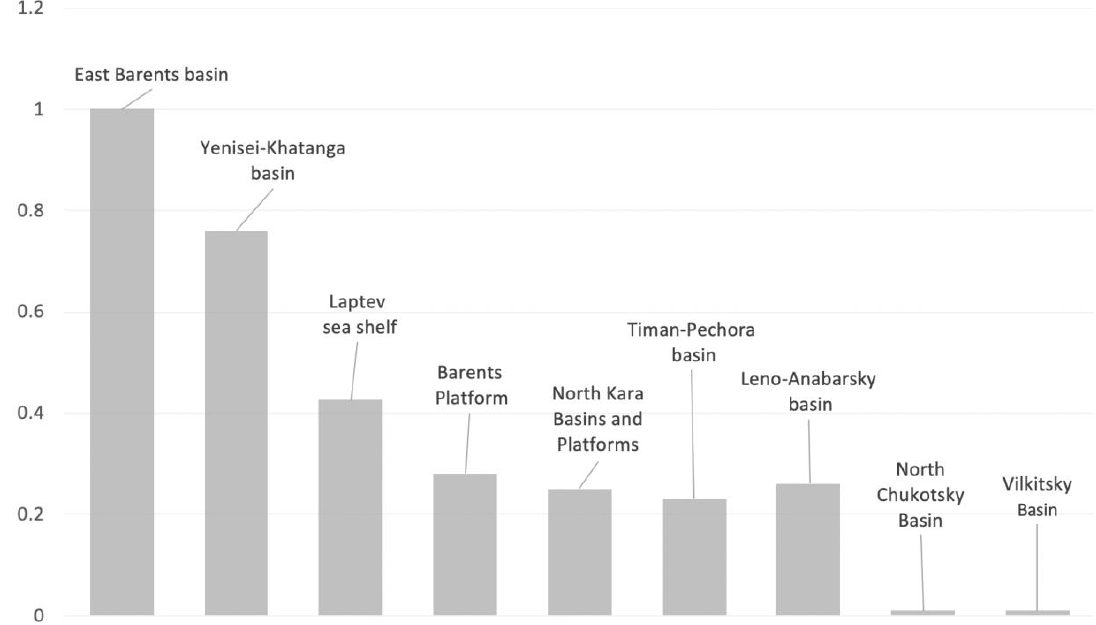
Figure 12. Estimation of oil resources in the Arctic basins of Russia (according to the United States Geological Survey (USGS) data [54]), billion